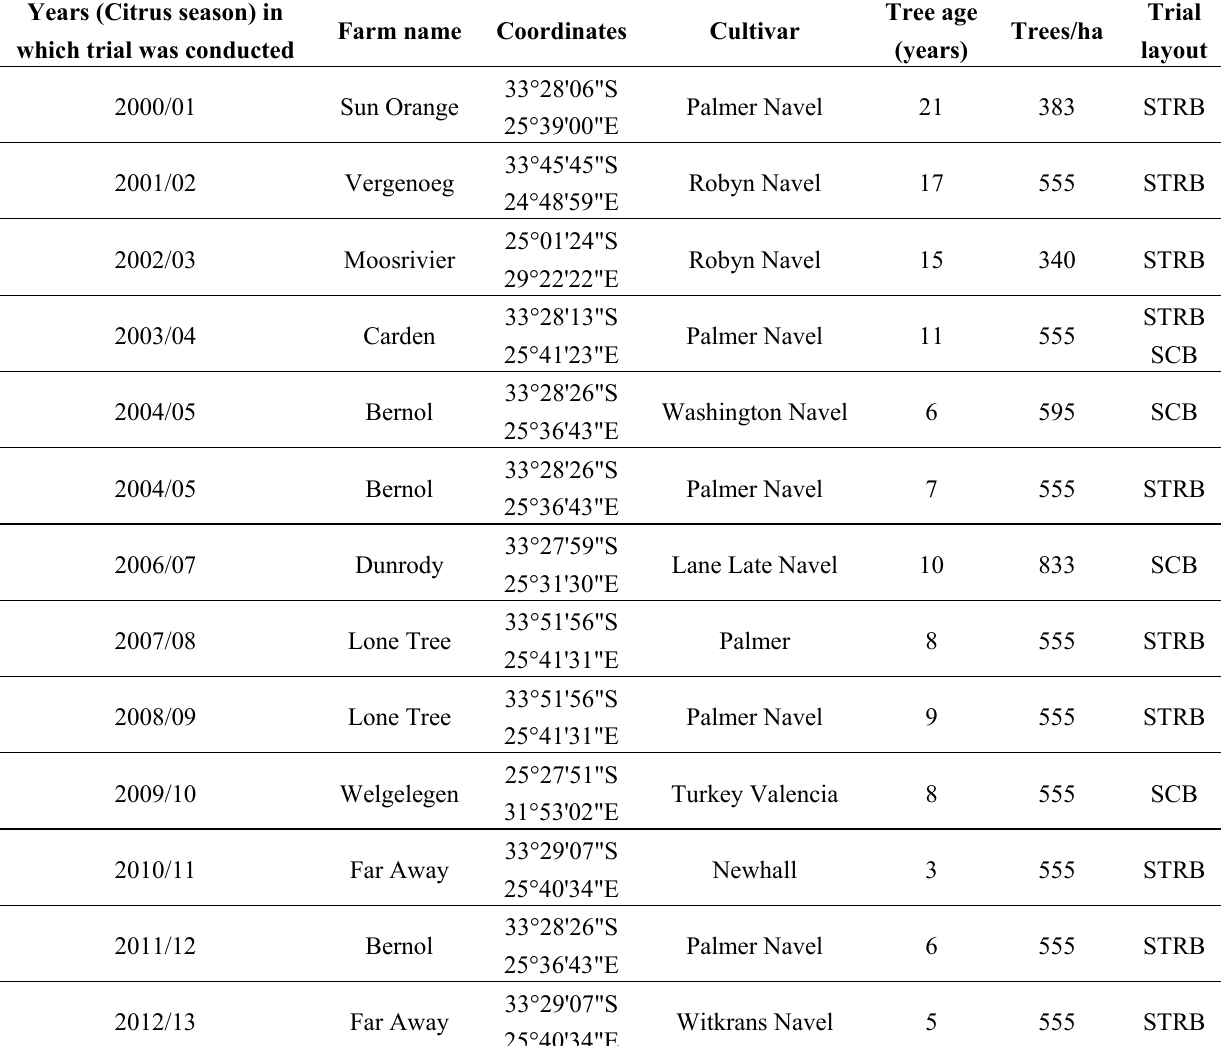
Table 2. Details of citrus trial sites where CrleGV was field tested against T. leucotreta